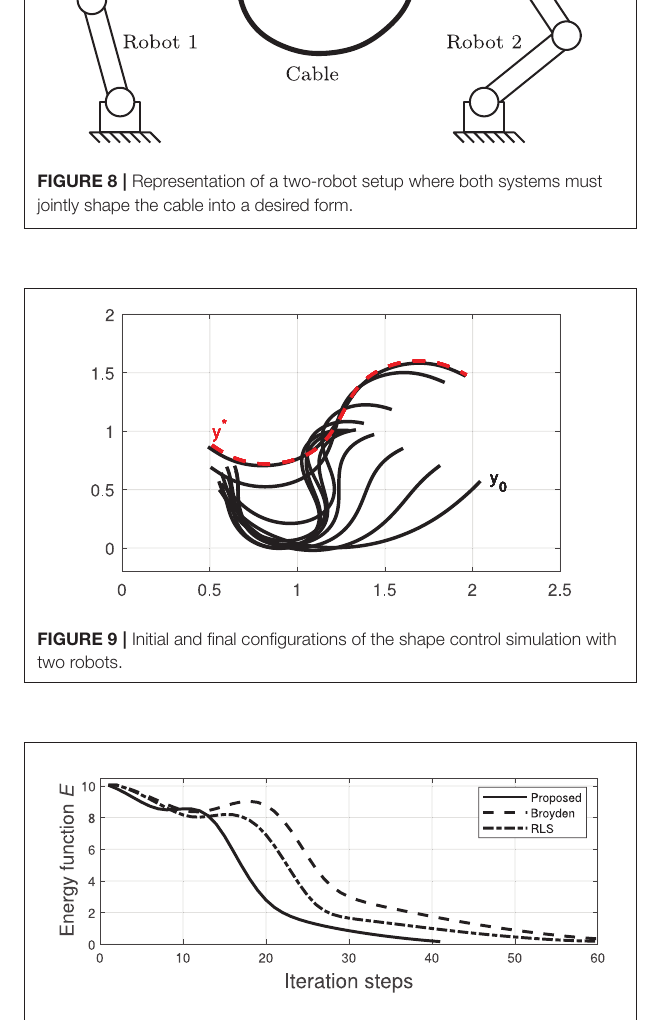
FIGURE 7 | Minimization process of the energy function E .